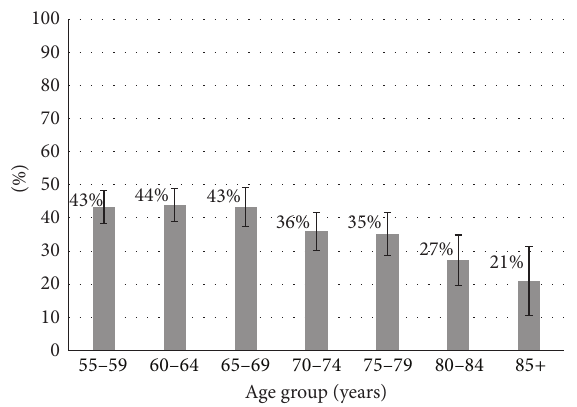
Figure 1: Older adults with ≥ 1 gun at home, by age group ( 𝑁 = 2939 ). Weighted proportion of older adults with ≥ 1 firearm in the home, by age group. Error bars represent 95% Confidence Intervals.